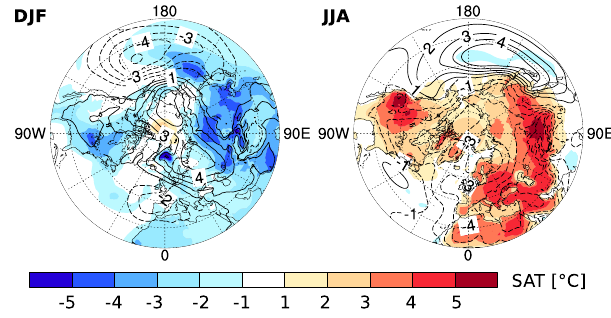
Figure 1. EEMpd–PI SAT ( ◦ C) (shaded) over SLP (hPa) (contour lines with labels) for DJF and JJA. The contour interval is 1hPa, negative values are dashed, and the zero line is not